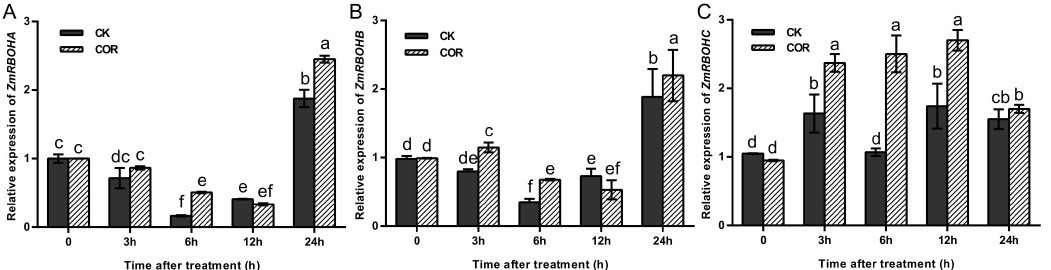
Figure 5. Expression patterns of ZmRBOHA ( A ), ZmRBOHB ( B ), and ZmRBOHC ( C ) in maize leaves exposed to COR. Relative expression levels of ZmRBOHA ( A ), ZmRBOHB ( B ), ZmRBOHC ( C ) genes, analyzed by real-time quantitative PCR, are presented as values relative to CK at 0 h, defined as 1, after normalization to β -tubulin transcript levels. Values are means ± standard error ( n = 3), and different letters indicate significant differences ( p < 0.05) among the